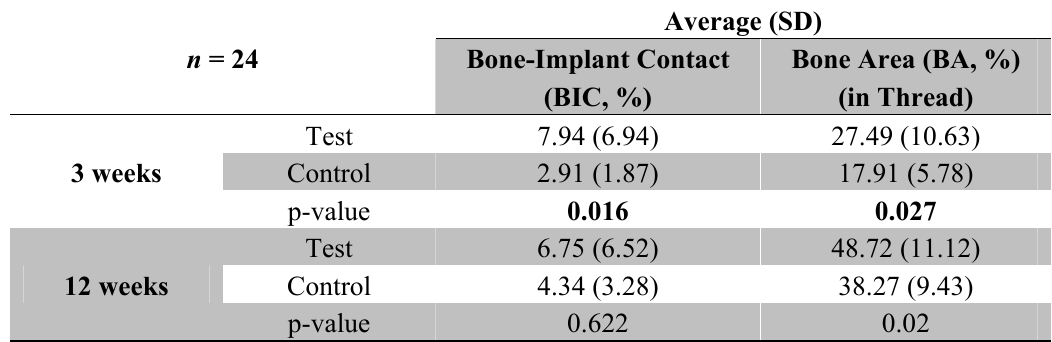
Figure 6. Histologic results. Masson Goldner-Trichrome stained sections of the implant after 3 and 12 weeks of healing. No soft tissue, or only sparse amounts (green), have migrated down between the implant and bone. Fibrous tissue (orange, arrow) can be viewed at the gap between the bone and implant, more commonly at the 3 week samples. ( A ) 3 weeks test (HA); ( B ) 3 weeks control; ( C ) 12 weeks test (HA); ( D ) 12 weeks control. Scale bar = 50 µm. Table 1. Histomorphometric results 3 and 12 weeks after